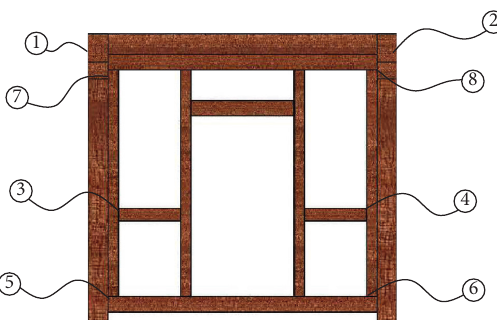
Figure 10: Arrangement of strain gauge.